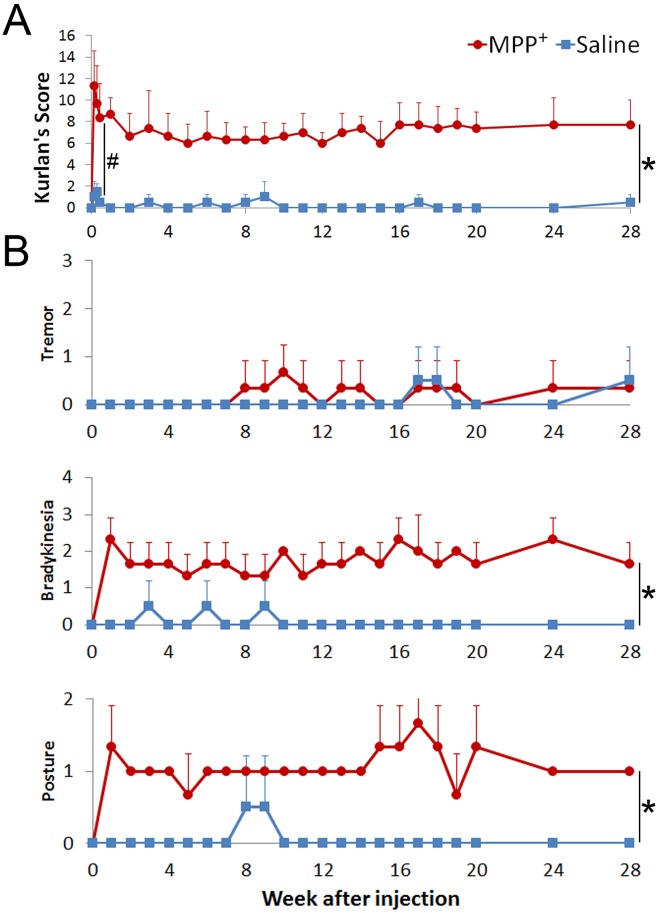
Quick-then-stable Parkinsonian symptoms.
(A) Kurlan Scores of monkeys administered MPP+ (N = 3) or saline (N = 2) directly to the SNc and striatum. One day after the infusion operation, the Kurlan scores of the MPP+ infused monkeys rose markedly, followed by a partial fall into a stable plateau, while control monkeys recovered quickly (#. P = 0.032). The Kurlan scores of the MPP+ infused monkeys maintained a plateau for 28 weeks and were significantly higher than controls (main effect of group, *. P = 0.012). The scores of both MPP+ and control monkeys showed no changing trend (main effect of time, P = 0.434) and were parallel (interaction effect of time and group, P = 0.396). (B) Stable individual PD symptom scores. Specific items related to typical symptoms of PD in the Kurlan scale also showed long-term stabilization. The grading of bradykinesia and posture, but not tremor, had significant differences between MPP+ and control monkeys (*. P = 0.007 and P = 0.001, respectively).